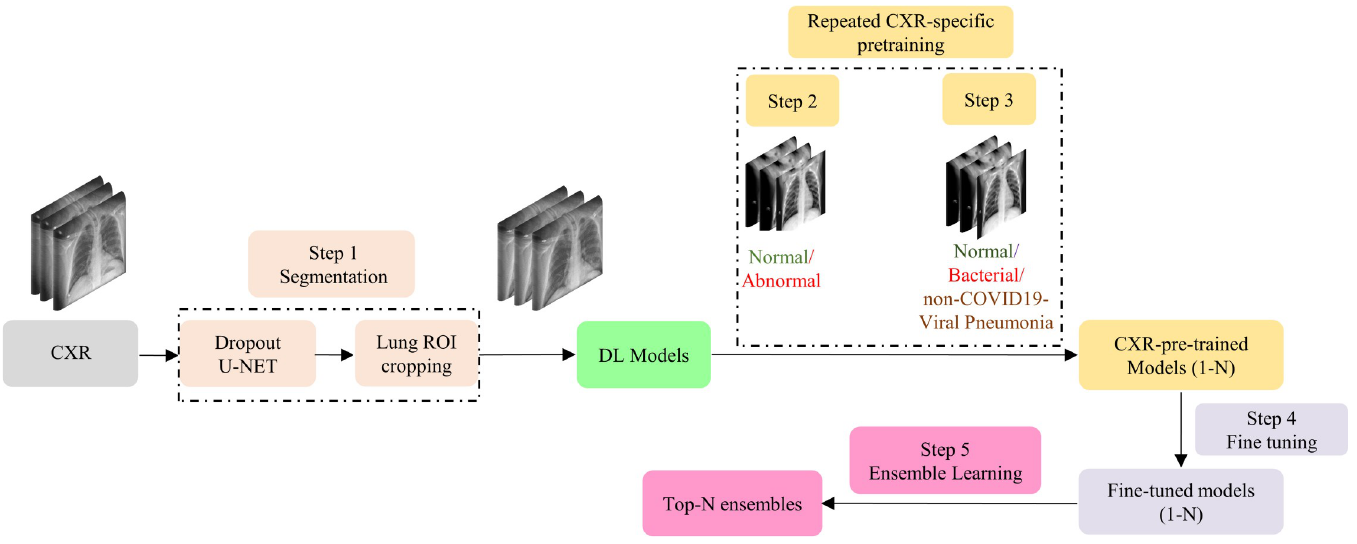
Fig 3. The workflow of the proposed repeated CXR-specific pretraining and fine-tuning.